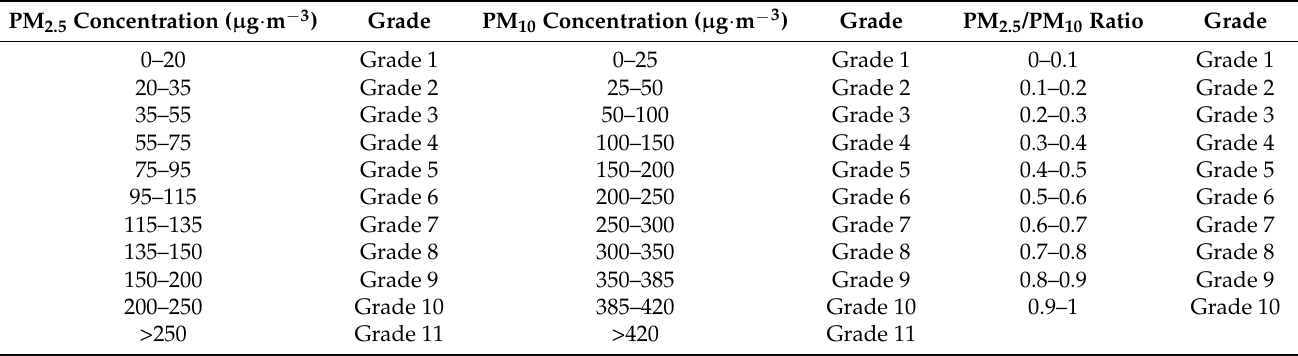
Table 1. Grade divisions of the PM concentration and PM 2.5 /PM 10 ratio introducing intermediate thresholds.